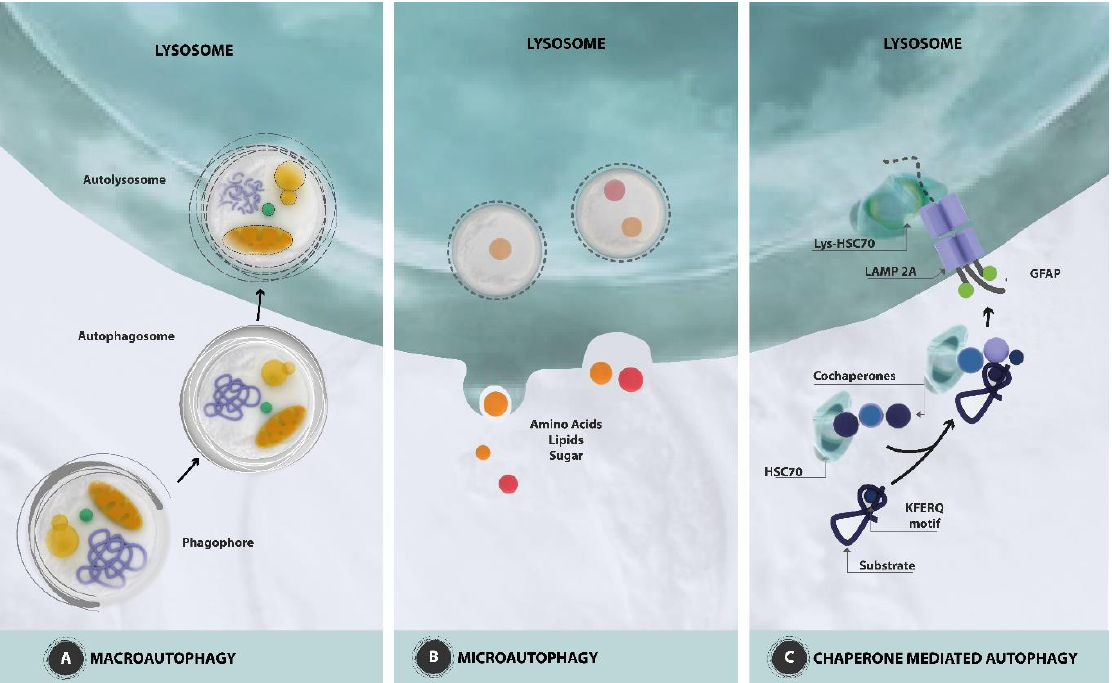
Figure 1. Schematic presentation of autophagic pathways. ( A ) Macroautophagy. The key event in macroautophagy is the de novo formation of a new organelle called the autophagosome, which surrounds and sequesters either random portions of the cytoplasm or selectively targets individual cytosolic components. Initially, double-membraned cup-shaped structures, called phagophores or membrane isolation, engulf the cytosolic cargo. The expansion of the double membrane ends with the completion of the autophagosome that is trafficked by microtubules. The fusion of the autophagosome with the lysosome constitutes an autolysosome where the trapped cargo can be degraded. ( B ) Microautophagy. The cytosolic cargo (amino acids, lipids, sugar) is translocated into the lysosomes for degradation via direct invagination, protrusion, or septation of the lysosomal limiting membrane. ( C ) Chaperone mediated autophagy. It selects a defined pool of proteins that contains the KFERQ motif and delivers them to lysosomes via the chaperone HSC70 and cochaperones. The complex formed by HSC70 and the KFERQ-containing protein interacts with the lysosome-associated surface membrane protein type 2A (LAMP2A). Then, the KFERQ-containing protein unfolds and is transported across the lysosome membrane by a lysosome form of HSC70 (lys-HSC70), which resides inside the lysosome. GFAP, glial fibrillary acidic protein.